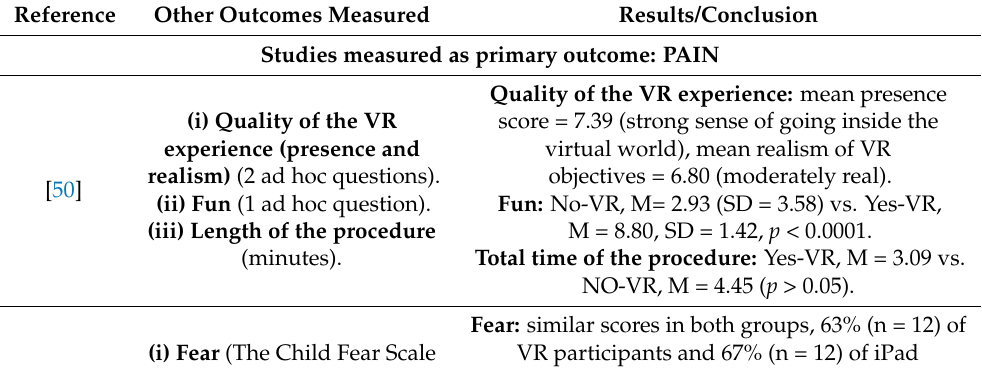
Table 6. Other outcomes measured across